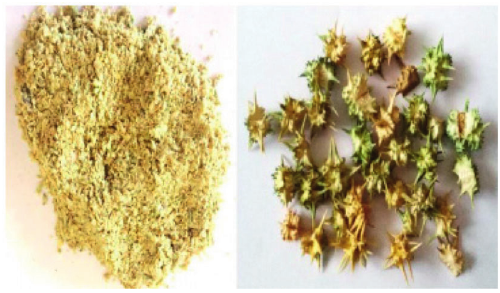
Figure 2: Tribulus terrestris seeds and their